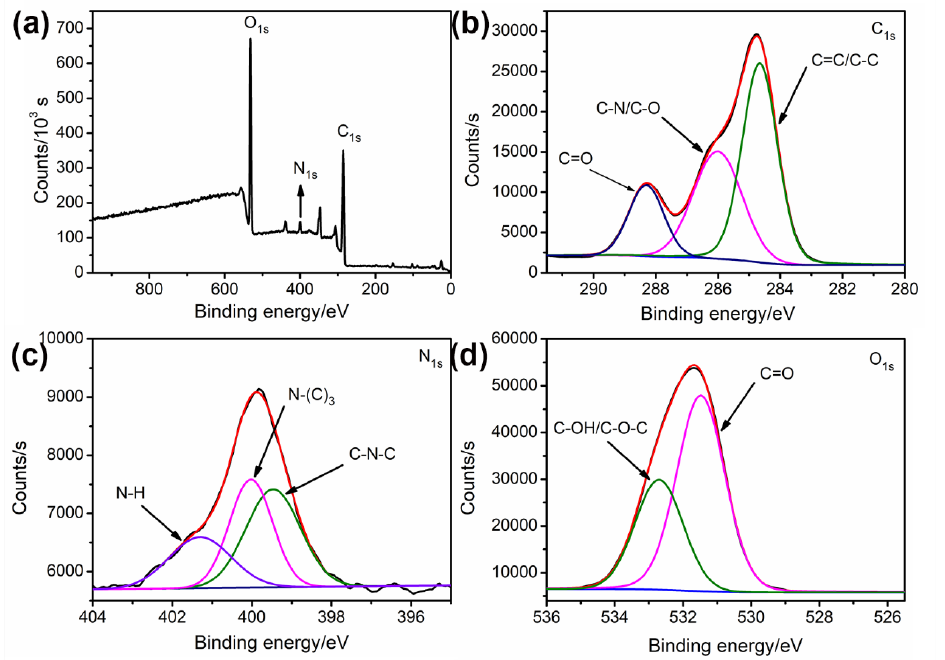
Figure 3. X-ray photoelectron spectroscopy (XPS) full survey ( a ); C 1s ( b ); N 1s ( c ) and O 1s ( d ) spectra Figure 3. XPS full survey ( a ), C 1s ( b ), N 1s ( c ) and O 1s ( d ) spectra of N-CNPs. Black line: raw, navy line: background, other lines: fitting. of N-CNPs. Black line: raw, navy line: background, other lines: